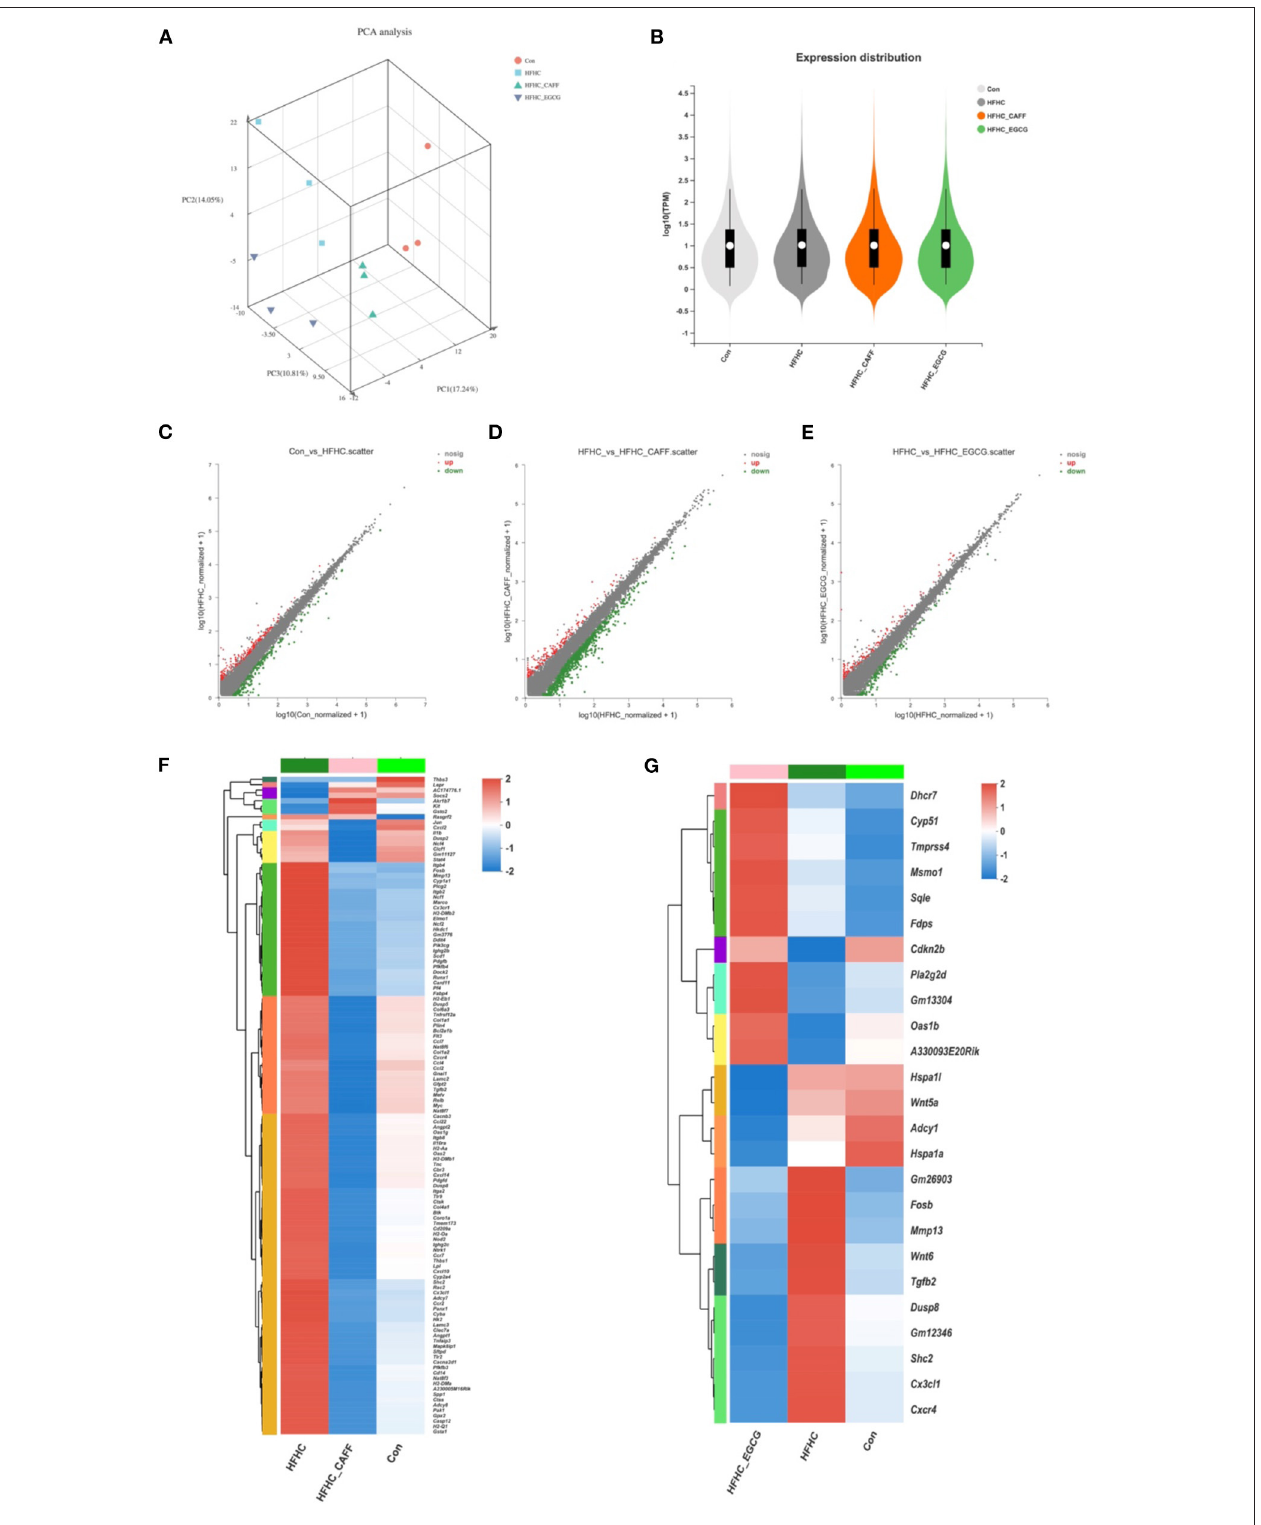
FIGURE 6 | Transcriptome characterization of liver tissue. (A) Transcriptomics PCA plots. Red circles indicate Con group, blue squares indicate HFHC group, light green triangles indicate CAFF group, purple triangles indicate EGCG group. (B) Violin plots show median (white point), quartiles (black bars), and kernel density estimation (violin) for each score distribution. Scatter plot analysis, Con vs. HFHC (C) , HFHC vs. CAFF (D) , HFHC vs. EGCG (E) . (F) Clustering heat map of HFHC vs. CAFF differential gene expression. (G) Clustering heat map of HFHC vs. EGCG differential gene expression.